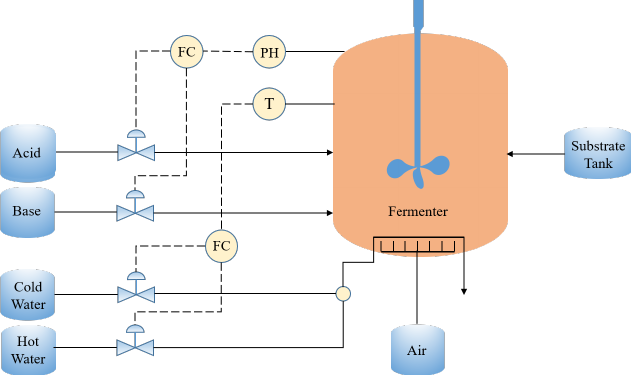
Figure 5. The penicillin fermentation reactor diagram.